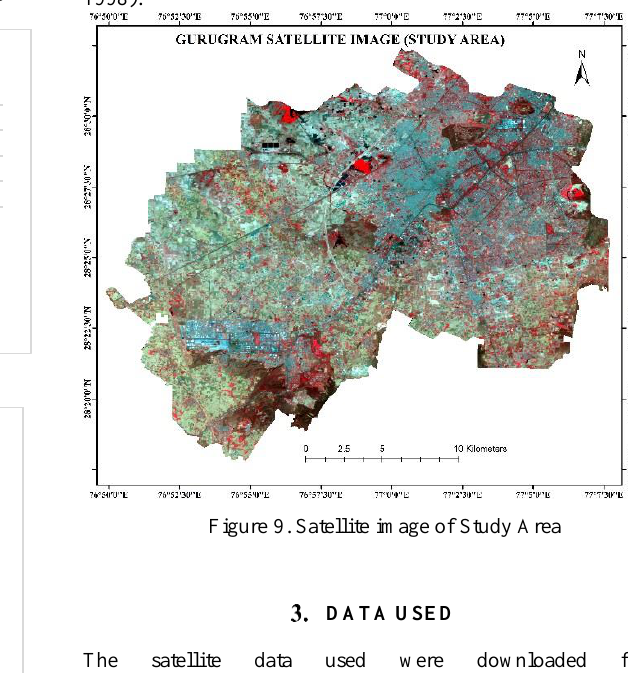
Figure 9. Satellite image of Study Area